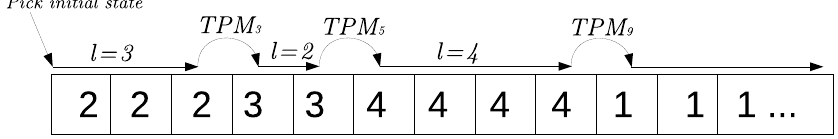
Figure 5. Example of activity sequence